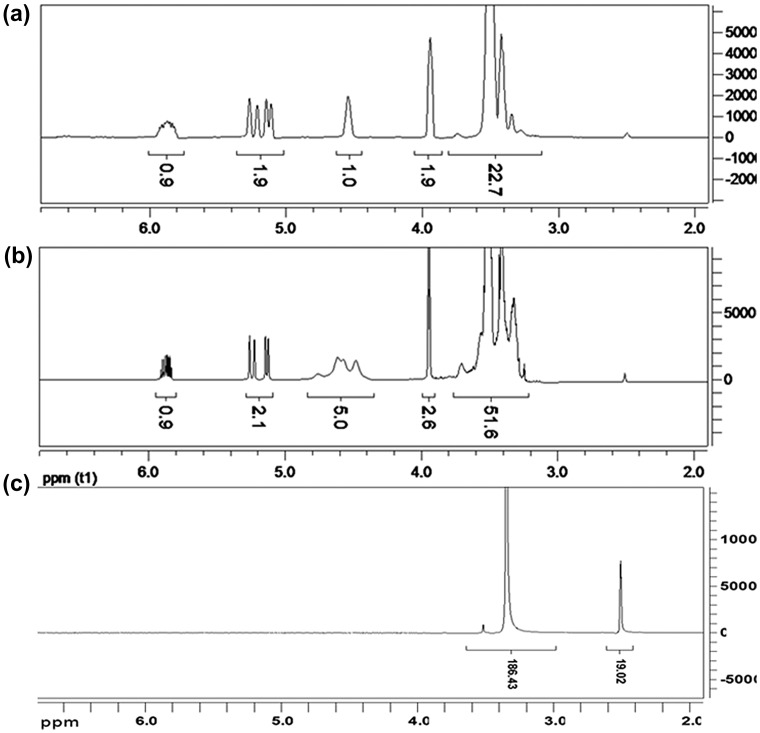

1H NMR spectra of APEG (a), APEG-PG-(OH)5 (b) and MA/APEG-PG-(OH)5 (c).